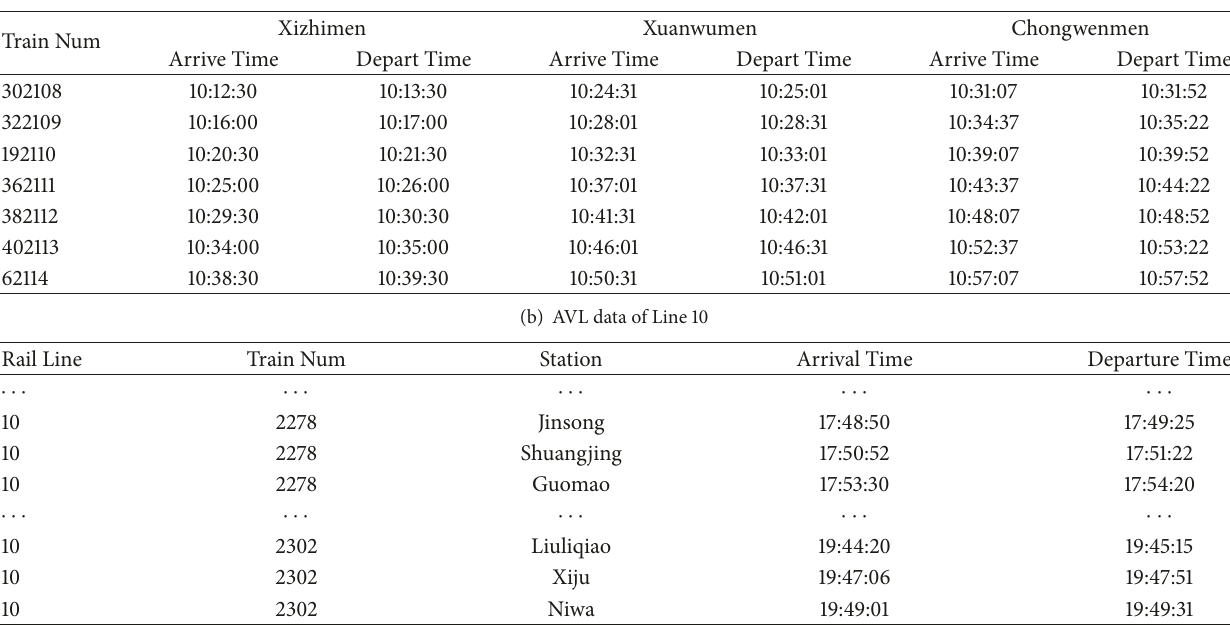
(a) Dongwuyuan access walking-time parameter comparison table